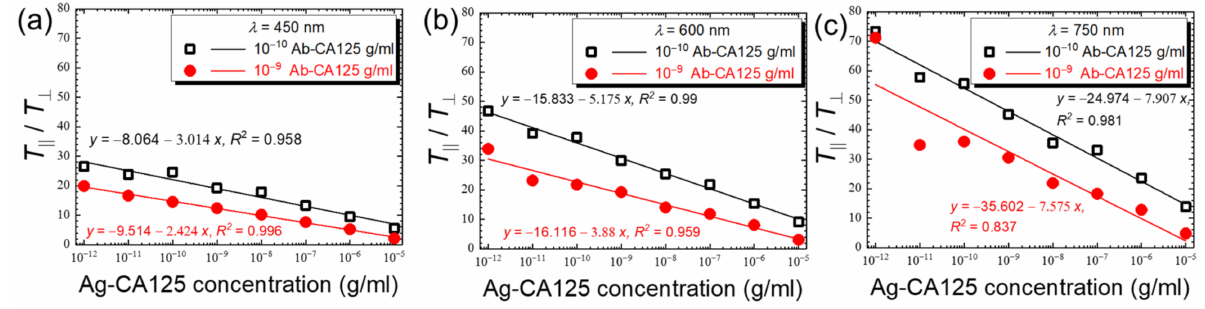
Figure 10. The correlation between CA125 concentration and the ratio of reduced transmittance at two immobilization concentrations of the anti-CA125 antibody, 10 − 10 and 10 − 9 g/mL. The ratios, T (cid:107) / T ⊥ , were calculated and plotted against the concentration of CA125 at selected wavelengths of ( a ) 450, ( b ) 600, and ( c ) 750 nm. The equation and coefficient of determination, R 2 , for each linear regression line are shown as a measure of agreement with the linear